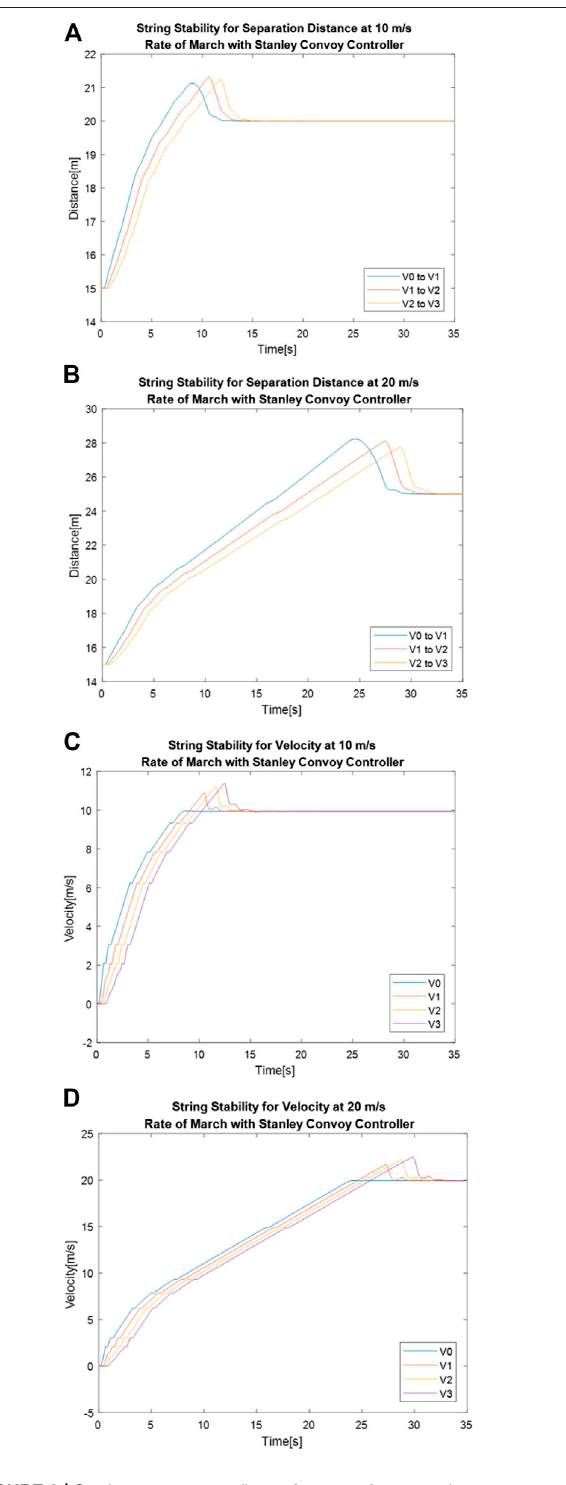
Frontiers in Robotics and AI |